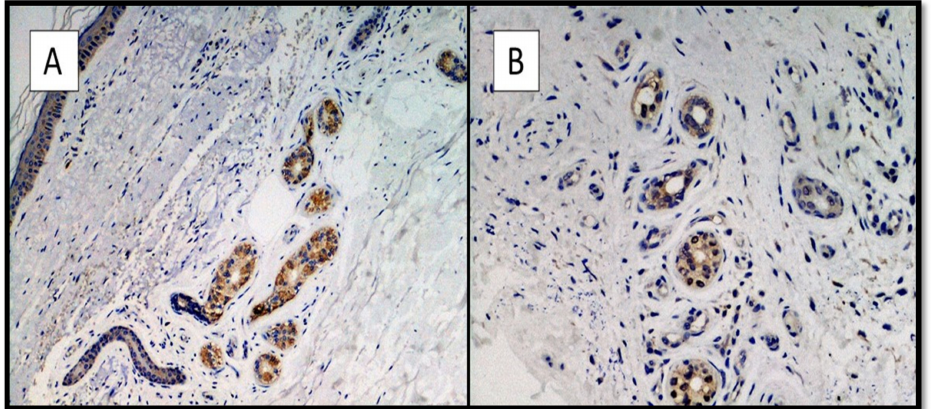
Figure 2. ( A , B ). Histological preparation for immunostaining with anti-SARS-CoV-2 S1 spike protein monoclonal antibody in a patient of the positive group. Note the granular, cytoplasmic positivity at the level of the cells constituting the eccrine sweat glands (IHC, Original Magnification: 10 × and 40 × ). In our nine cases of SARS-CoV-2 and in the controls, we found a fair degree of overlapping positivity for ACE2. A high expression (>3 in absolute value) was found in 9/9 cases (100.00%) in the samples taken from virus-positive patients, and in 8/9 subjects (88.8%) in the control group ( p = 0.9758) (Figure 3). The immuno-expression for ACE2